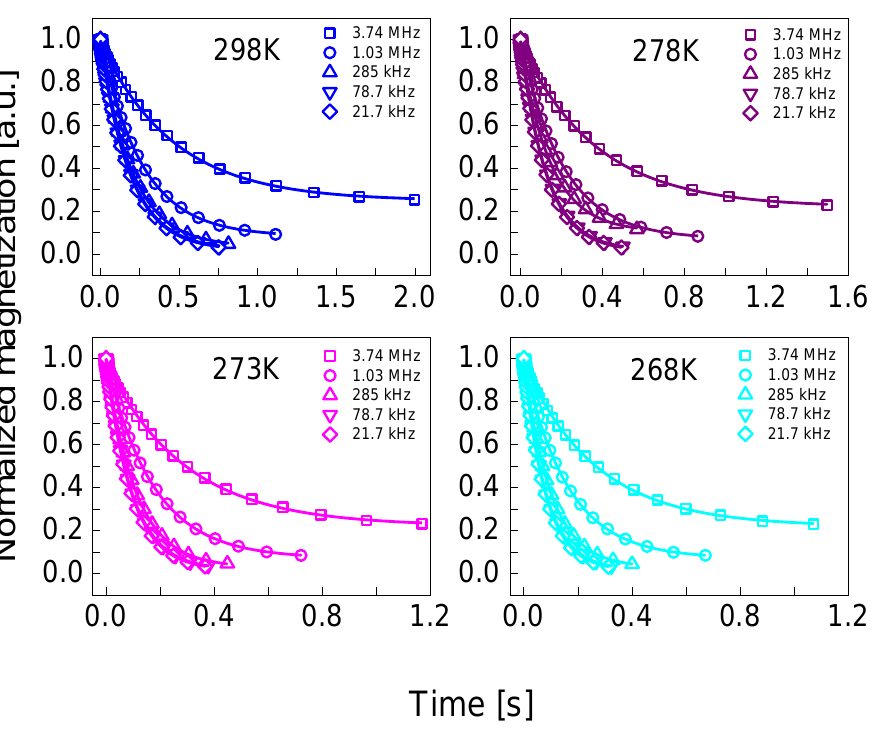
Figure A1. Normalized 1 H magnetization curves for BSA – water mixture (20%wt BSA) at selected resonance frequencies in the temperature range from 298 K to 268 K. Solid lines — single exponential fits.